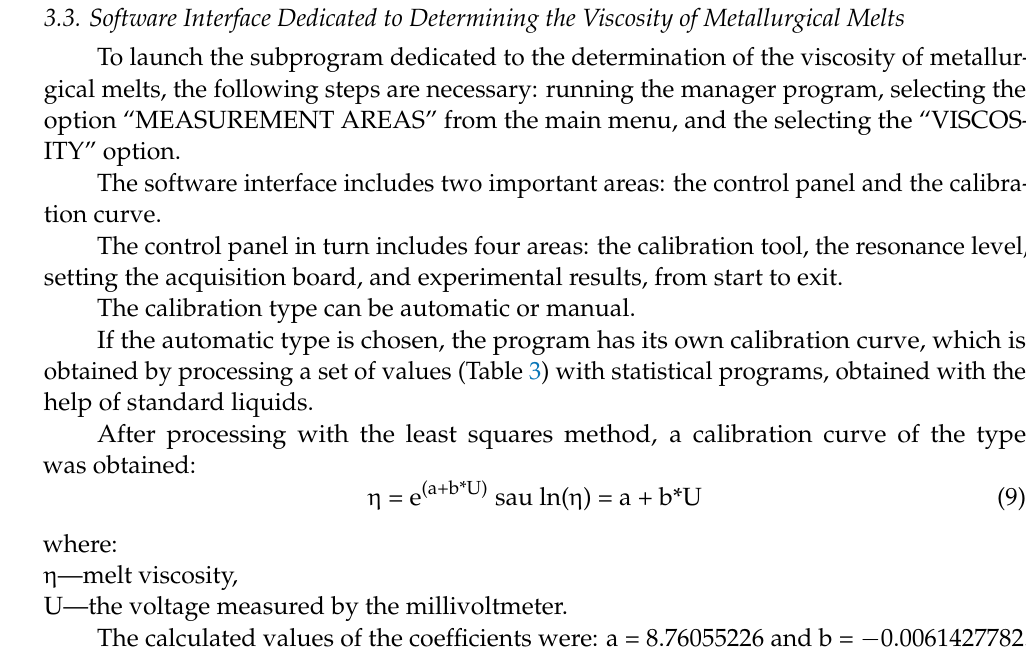
Figure 6a–e show images of the temperature sensors used in the conducted